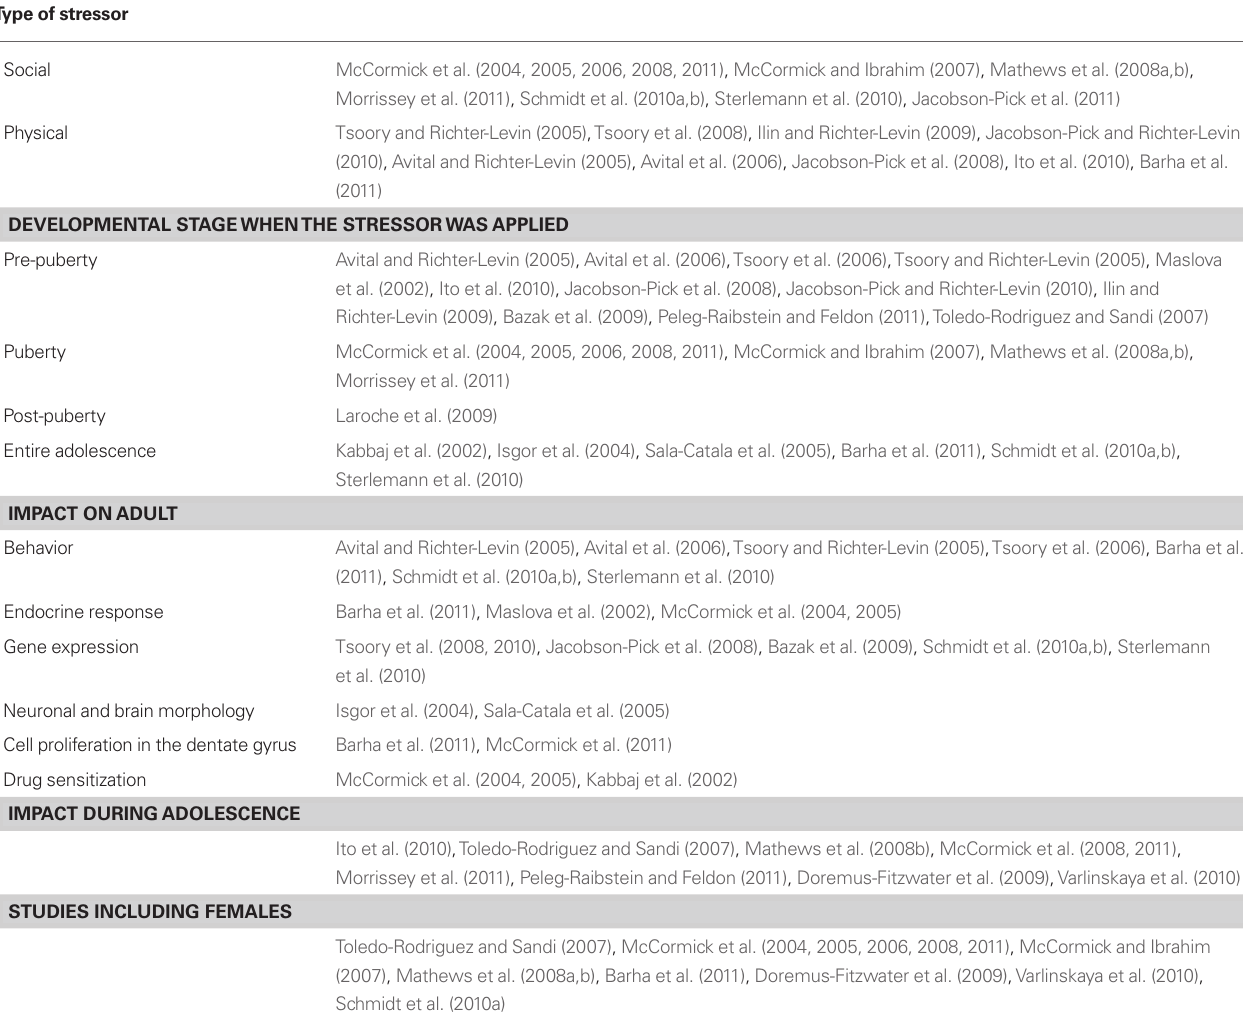
Table 1 | Studies investigating the effects of stress during adolescence in